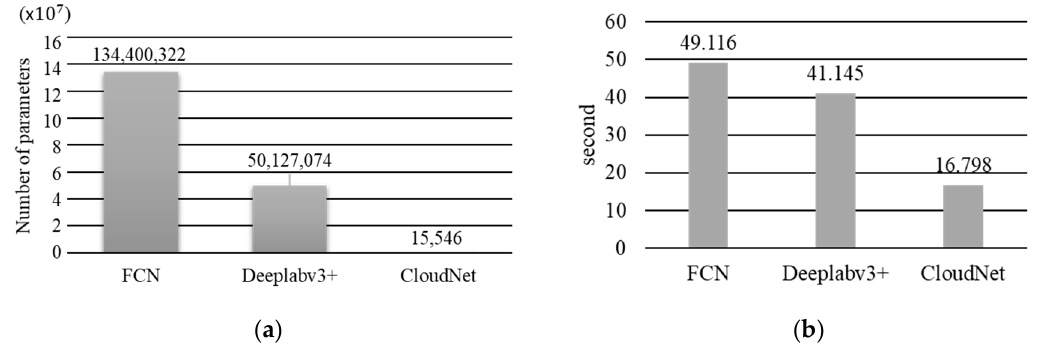
Figure 11. Comparison of the FCN, Deeplab v3+, and CloudNet in terms of ( a ) the number of parameters; and ( b ) the time for cloud classification.